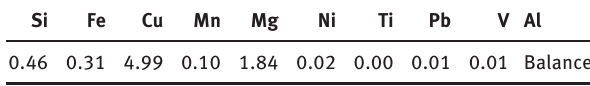
Table 1 Chemical composition of the matrix alloys (wt.%).